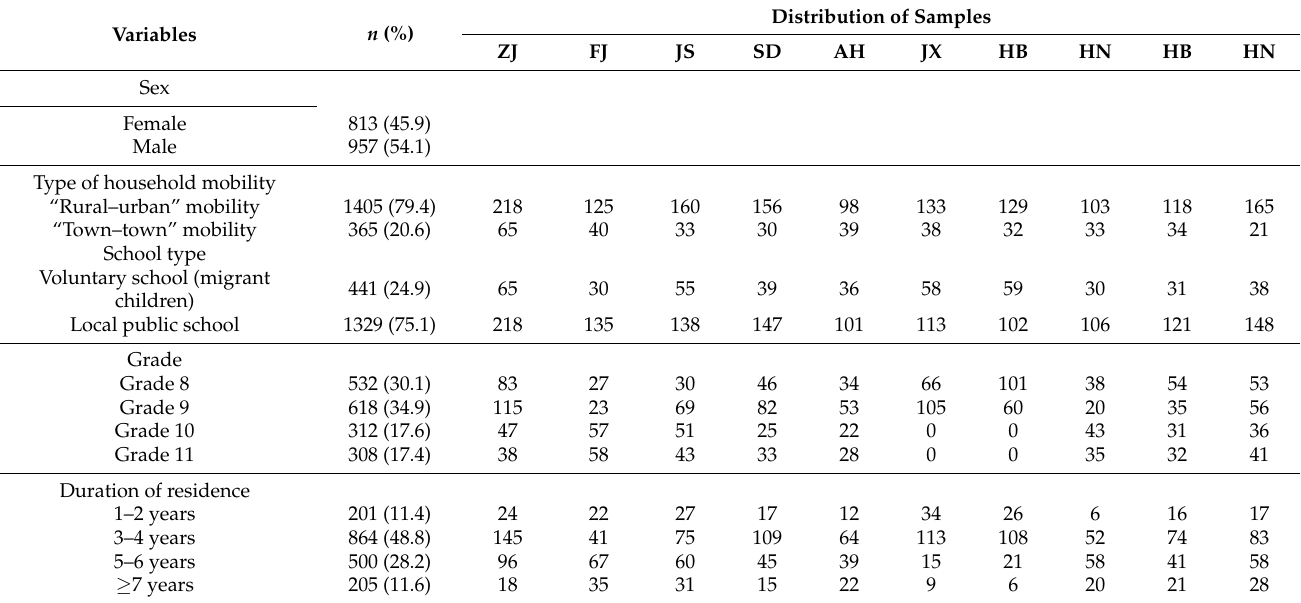
Table 1. Demographic characteristics of the